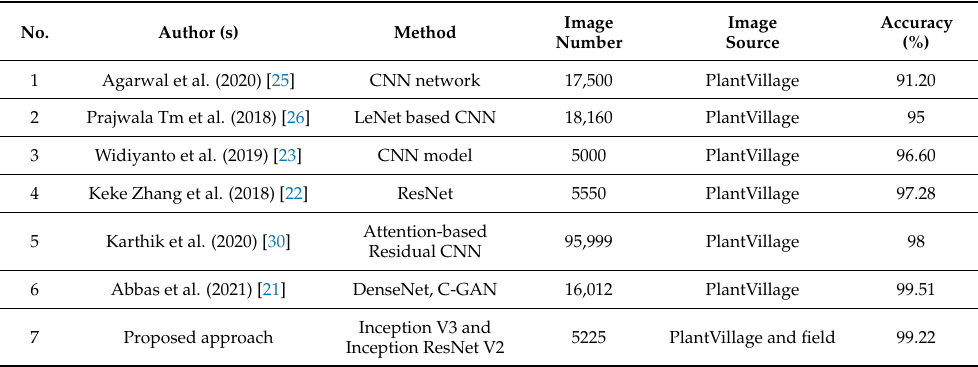
Figure 8. The relationship between accuracy and loss with the number of epochs for the dataset before and after fine-tuning Inception ResNet V2 model at 5%, 10%, 15%, 20%, 25%, 30%, 40%, and 50% dropout values.